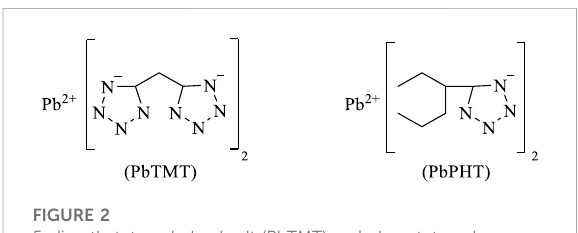
FIGURE 2 5-dimethytetrazole lead salt (PbTMT) and phenytetrazole lead salt (PbPHT) (Zhao et al.,